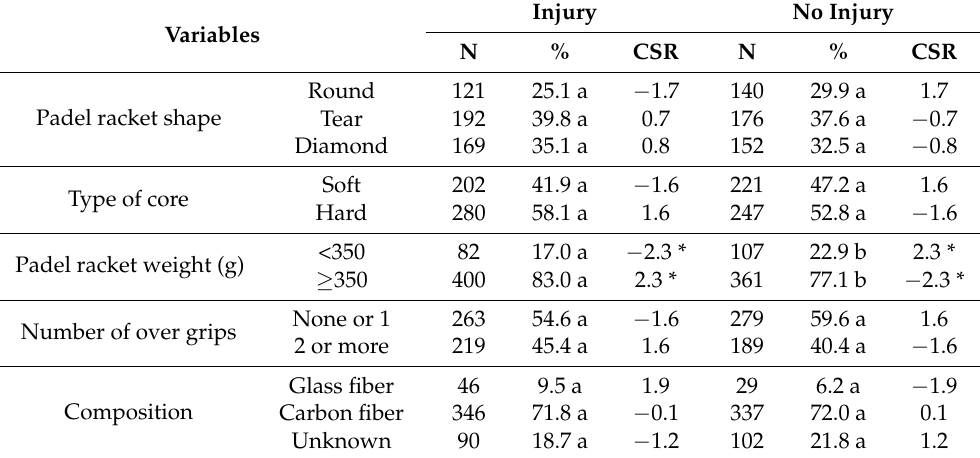
Table 5. Relationship between injury and racket characteristics in amateur padel